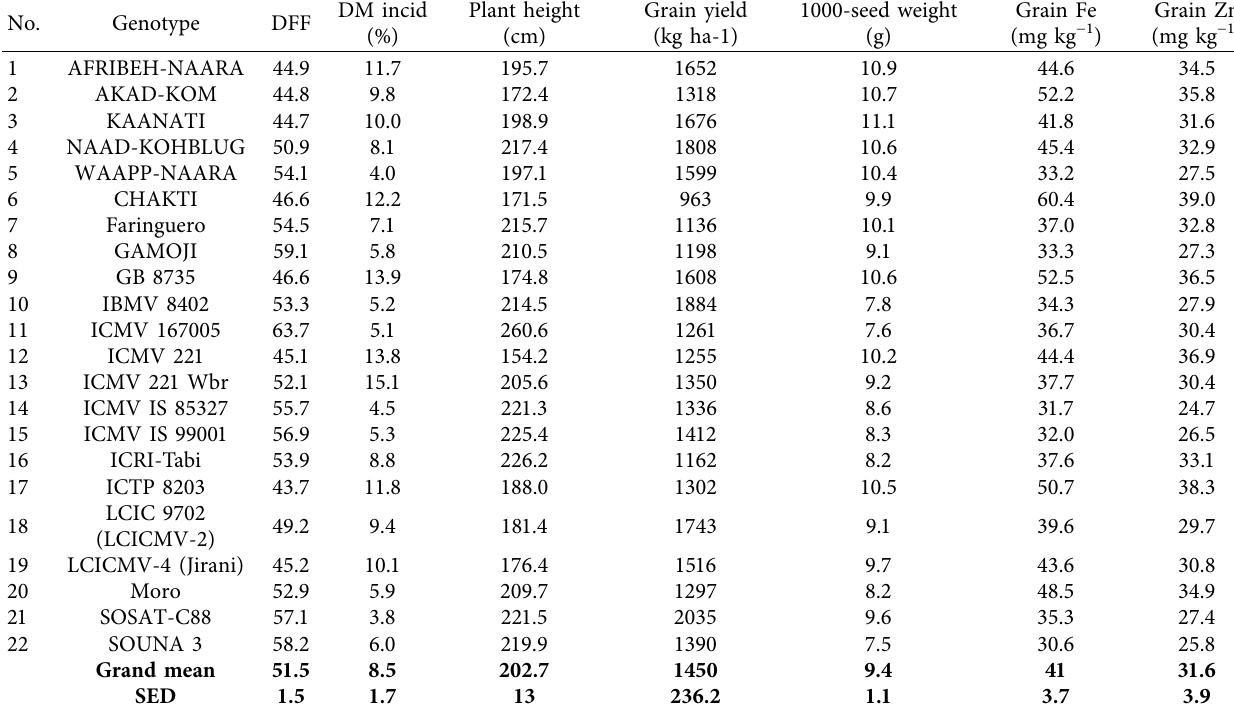
Table 6: Mean performance of 22 pearl millet OPVs evaluated in two locations over three seasons in northern Ghana.